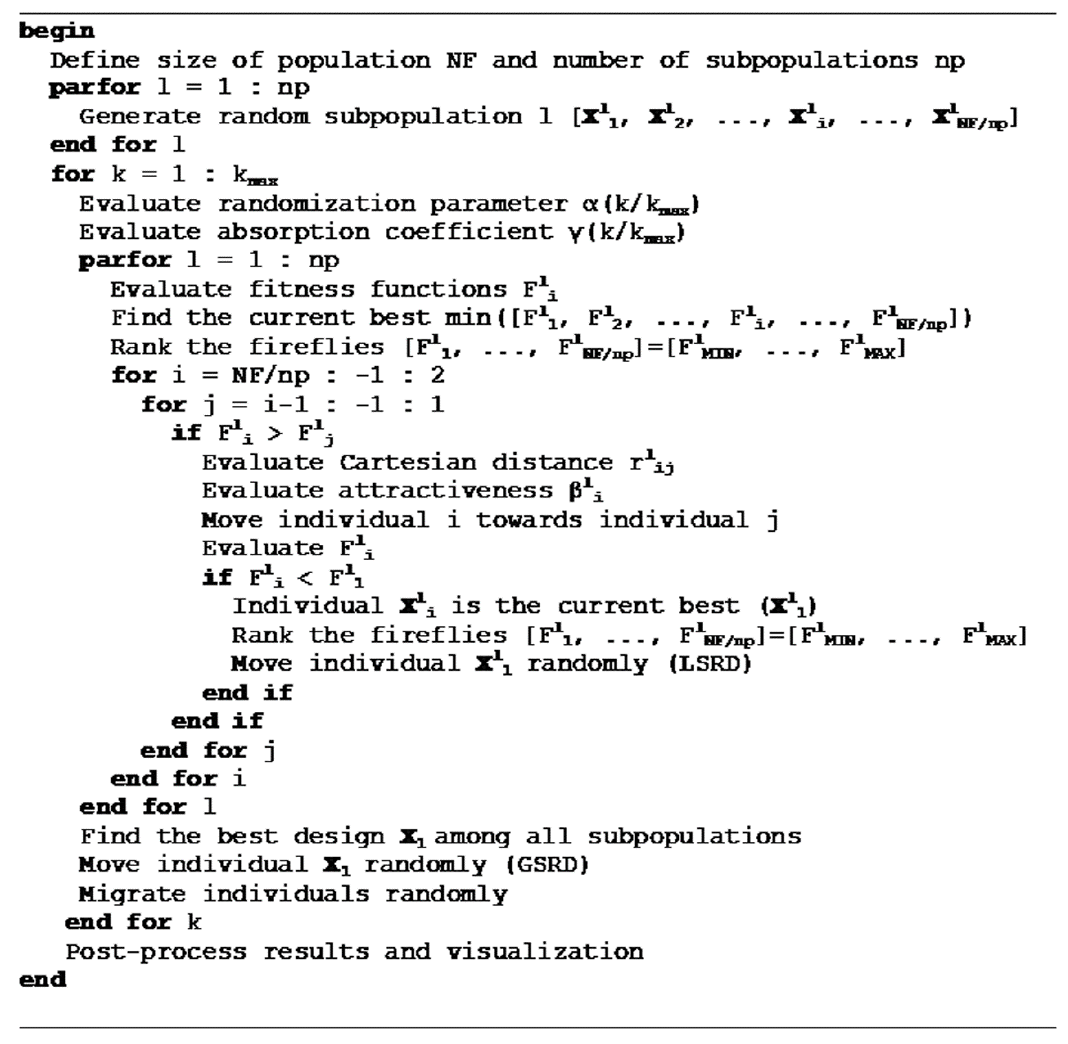
Figure 2. Pseudo-code of modified version (MPFA).